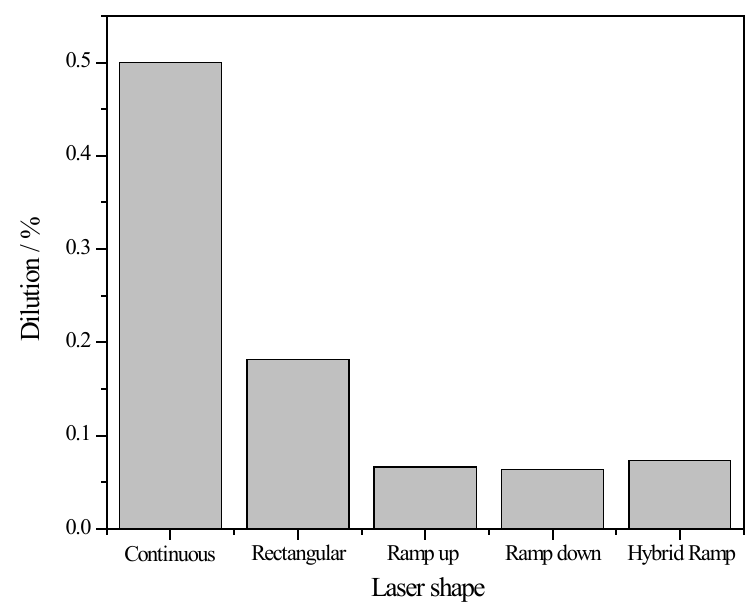
Figure 5. The dilutions of single-track with different laser shape.